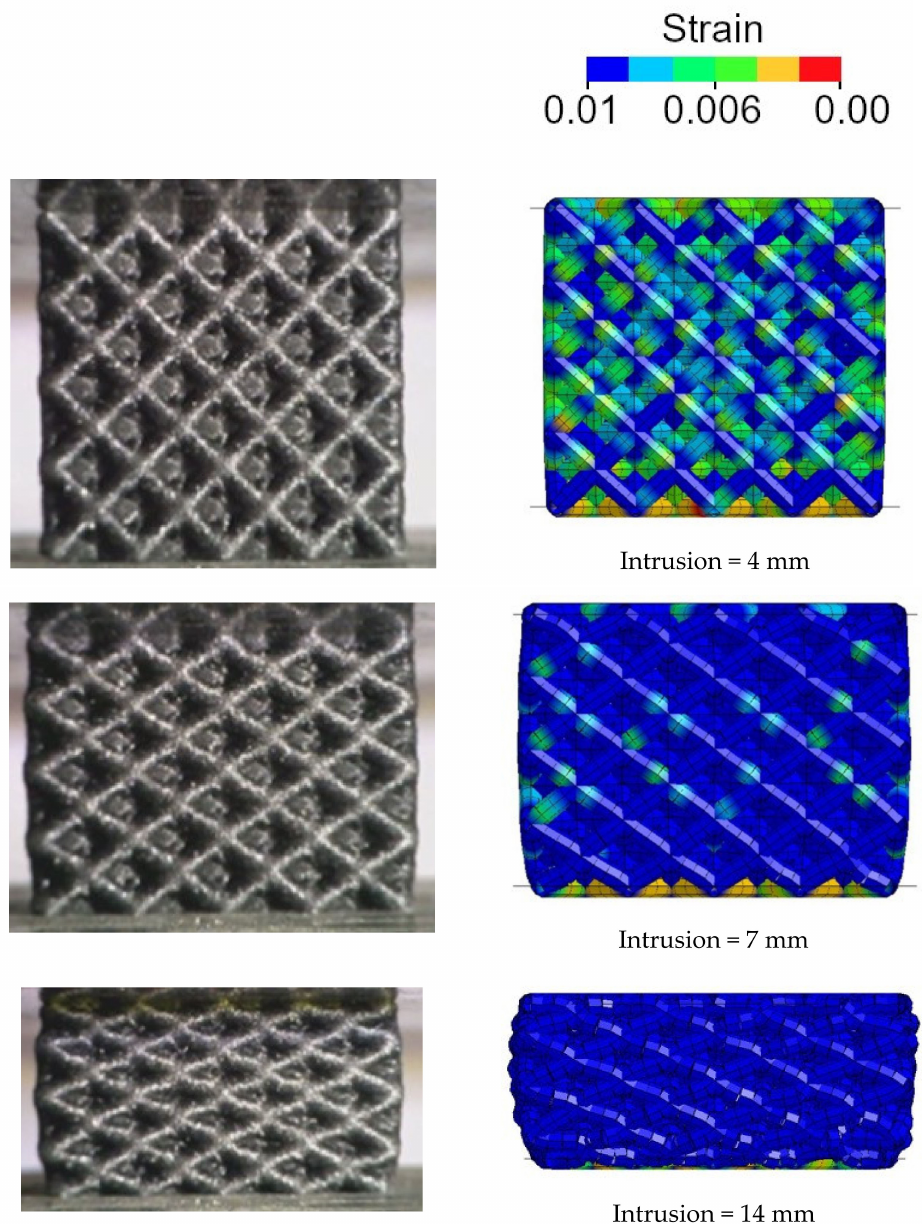
Figure 12. Experimental and numerical compression sequence of the A4B3 lattice structure: plastic strain contour plot in the numerical